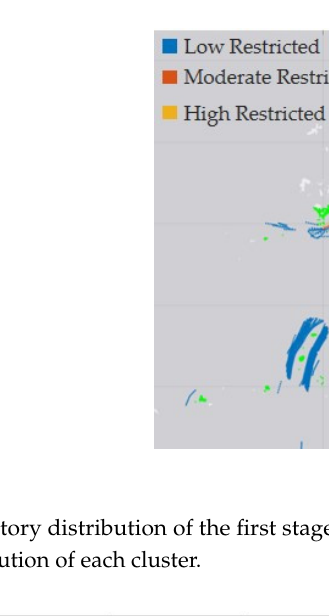
Figure 10. Visualization of the sample CRS. The green color indicates the ENC object, the blue indicates the own ship, and the red indicates the target ship.